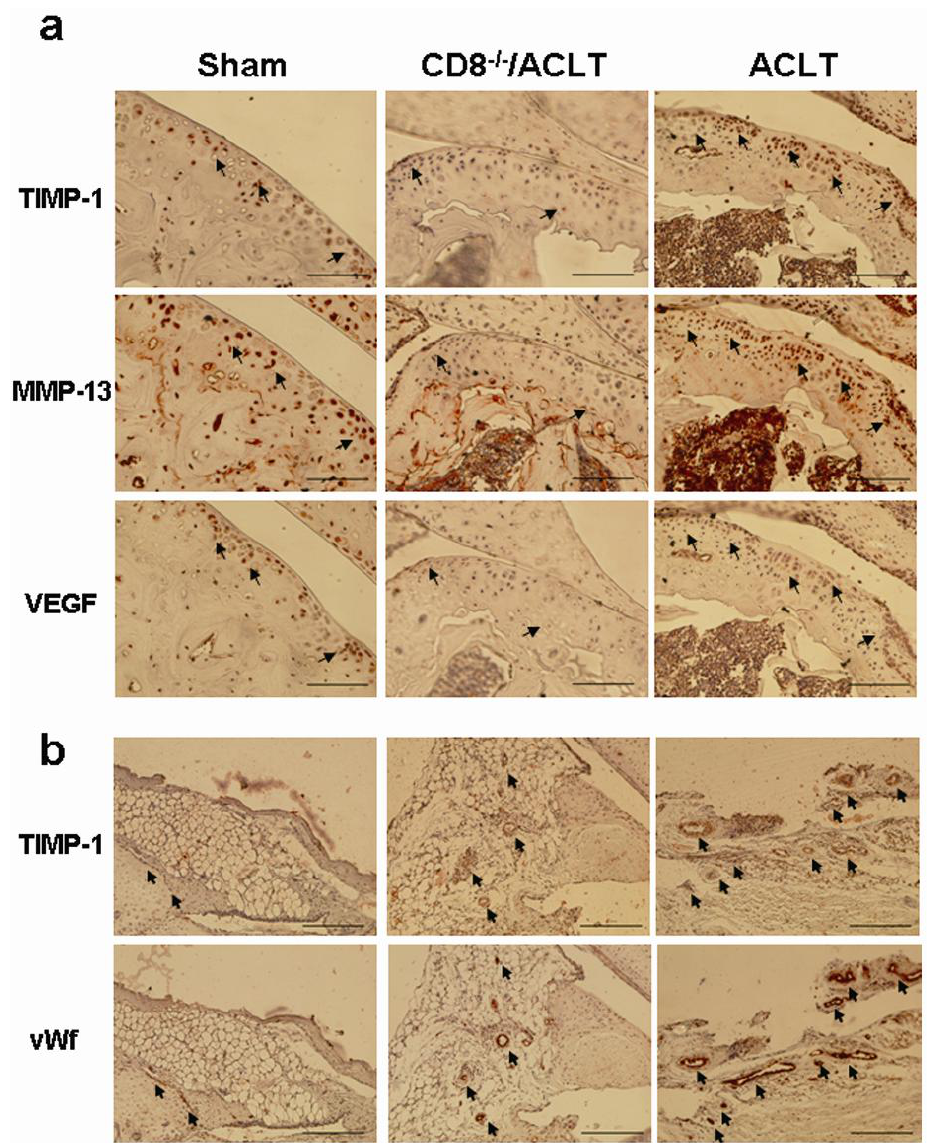
Figure 6. Immunohistochemical staining for TIMP-1, MMP-13, and VEGF in the joints of mice with OA. Representative immunohistochemical images of the cartilage and synovium are shown ( n = 5 per group) ( a ) Higher TIMP-1, MMP-13, and VEGF expression was seen in the superficial cartilage and in the osteochondral cartilage junctions of ACLT-group mice than in Sham- and CD8 −/− /ACLT-group mice 90 days post-surgery (IHC stain; 200× magnification; scale bar = 50 µm). The overlapped locations of three gene expressions are indicated with arrows; and ( b ) Higher TIMP-1 expression and more abundant angiogenesis were seen in ACLT-group mice synovia than in Sham- and CD8 −/− /ACLT-group mice synovia (IHC stain; 200× magnification; scale bar = 50 µm). The overlapped locations of TIMP-1 and vWf expression are indicated with